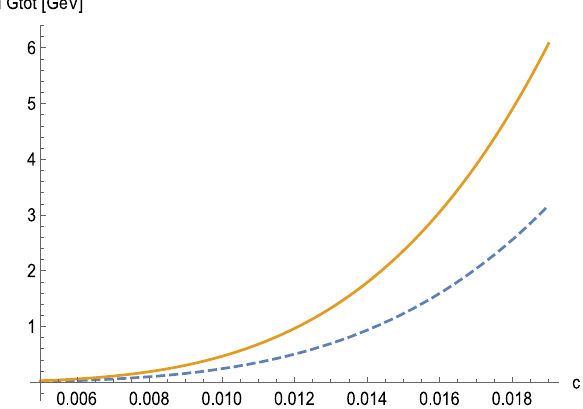
Fig. 1 Solid (orange) line: total decay width of the pseudoscalar glue- = 2 . 6 GeV as function of the coupling ball with the bare mass M ˜ G = 2 . 37 c Dashed (blue) line: the same curve for M ˜ G